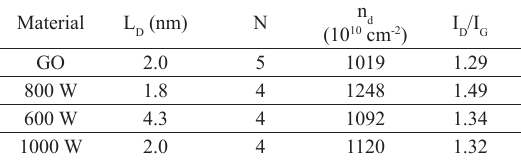
Figure 5. Raman spectra of GO and RGO at the different powers were Table 3. Raman spectroscopy results.